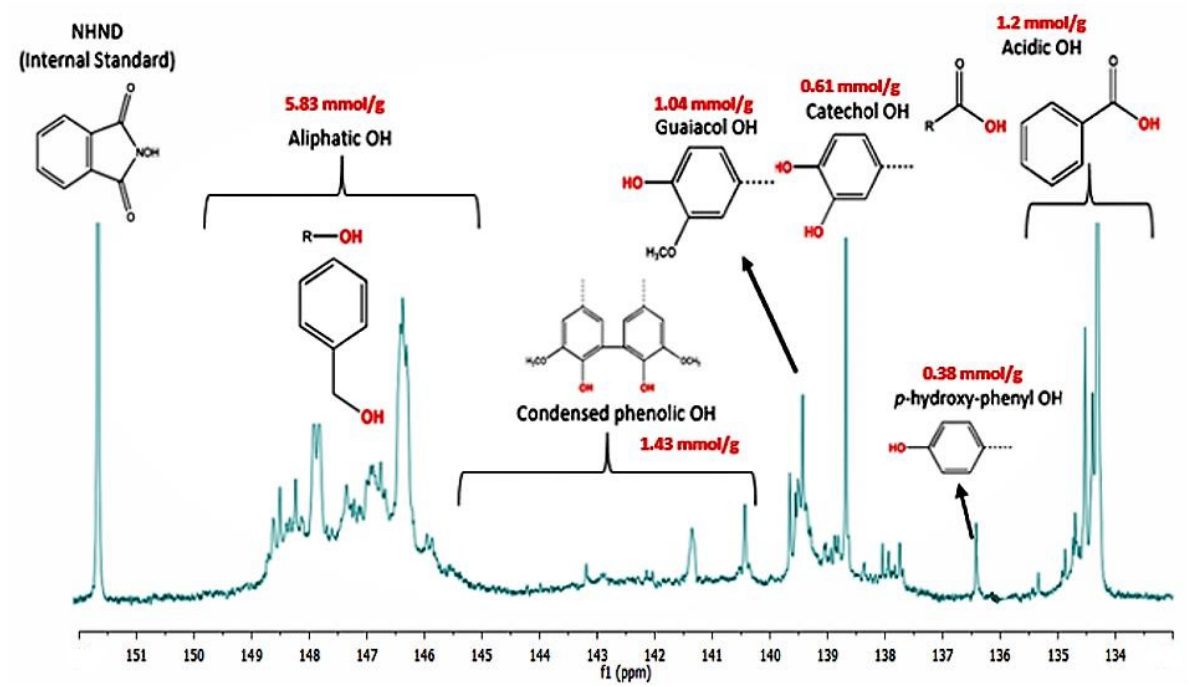
Figure 1. 31 PNMR analysis of fast pyrolysis bio-oil.